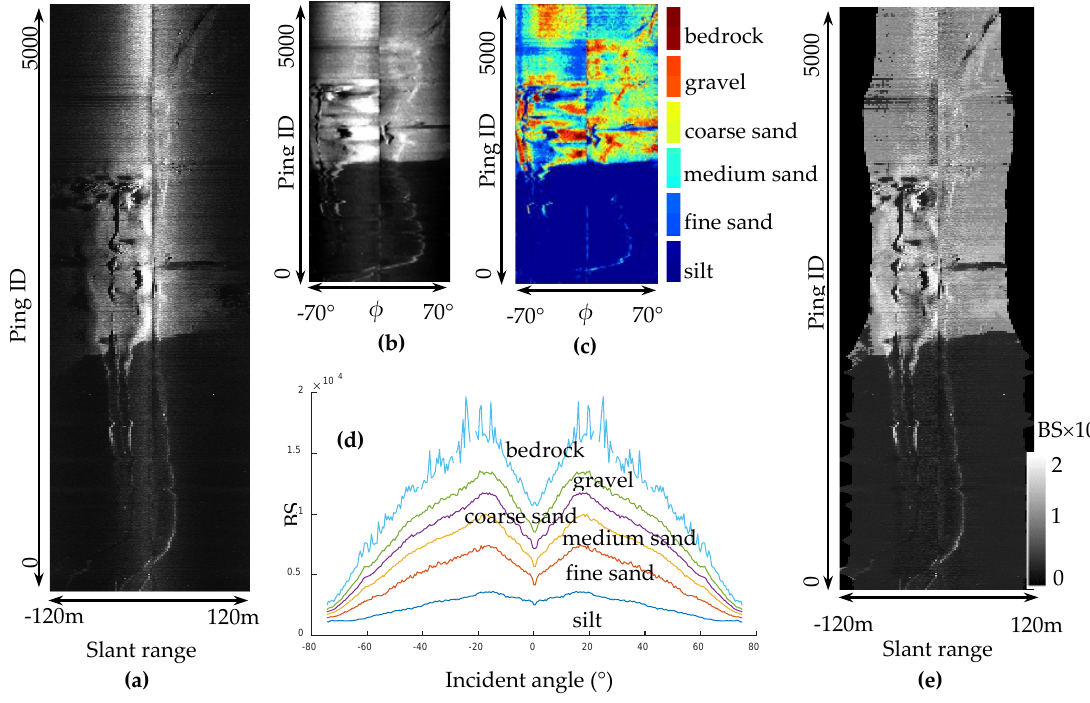
Figure 13. Radiometric correction of SSS image with various sediments: ( a ) raw SSS waterfall image; ( b ) angular waterfall image; ( c ) sediment classification image; ( d ) average angle–BS curves of the six sediments; and ( e ) new image after radiometric correction. φ in ( b , c ) denotes the incident angle.